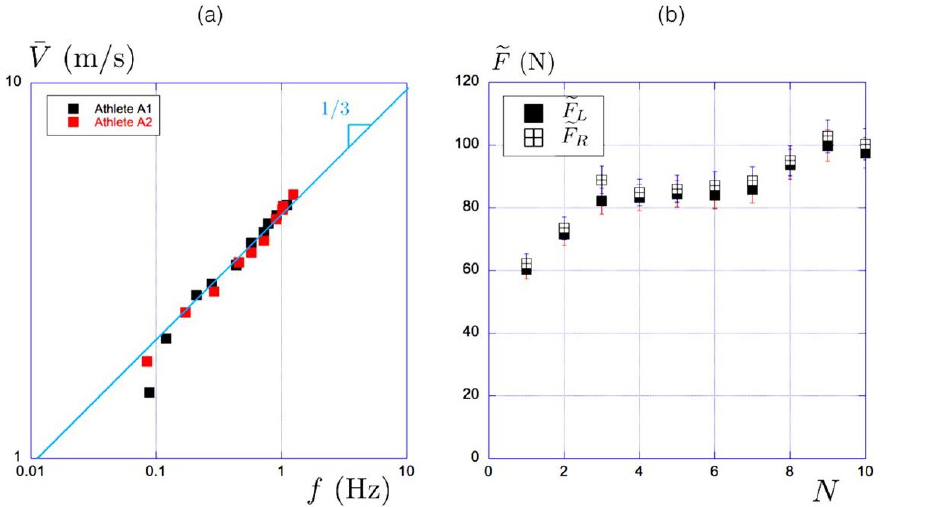
Figure 14. ( a ) Velocity–stroke rate relationship in the steady state regime for the two kayakers. ( b ) Evolution of the average propulsion force in the direction of paddling with trial N for Athlete A1. The force is averaged over the propulsion